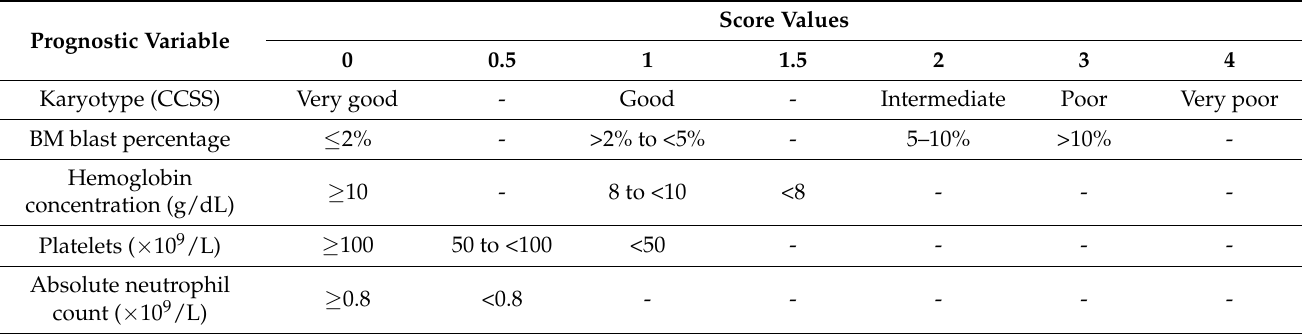
Table 2. The Revised International Prognostic Scoring System (IPSS-R) score values for myelodys- plastic syndromes. Adapted from Greenberg et al.